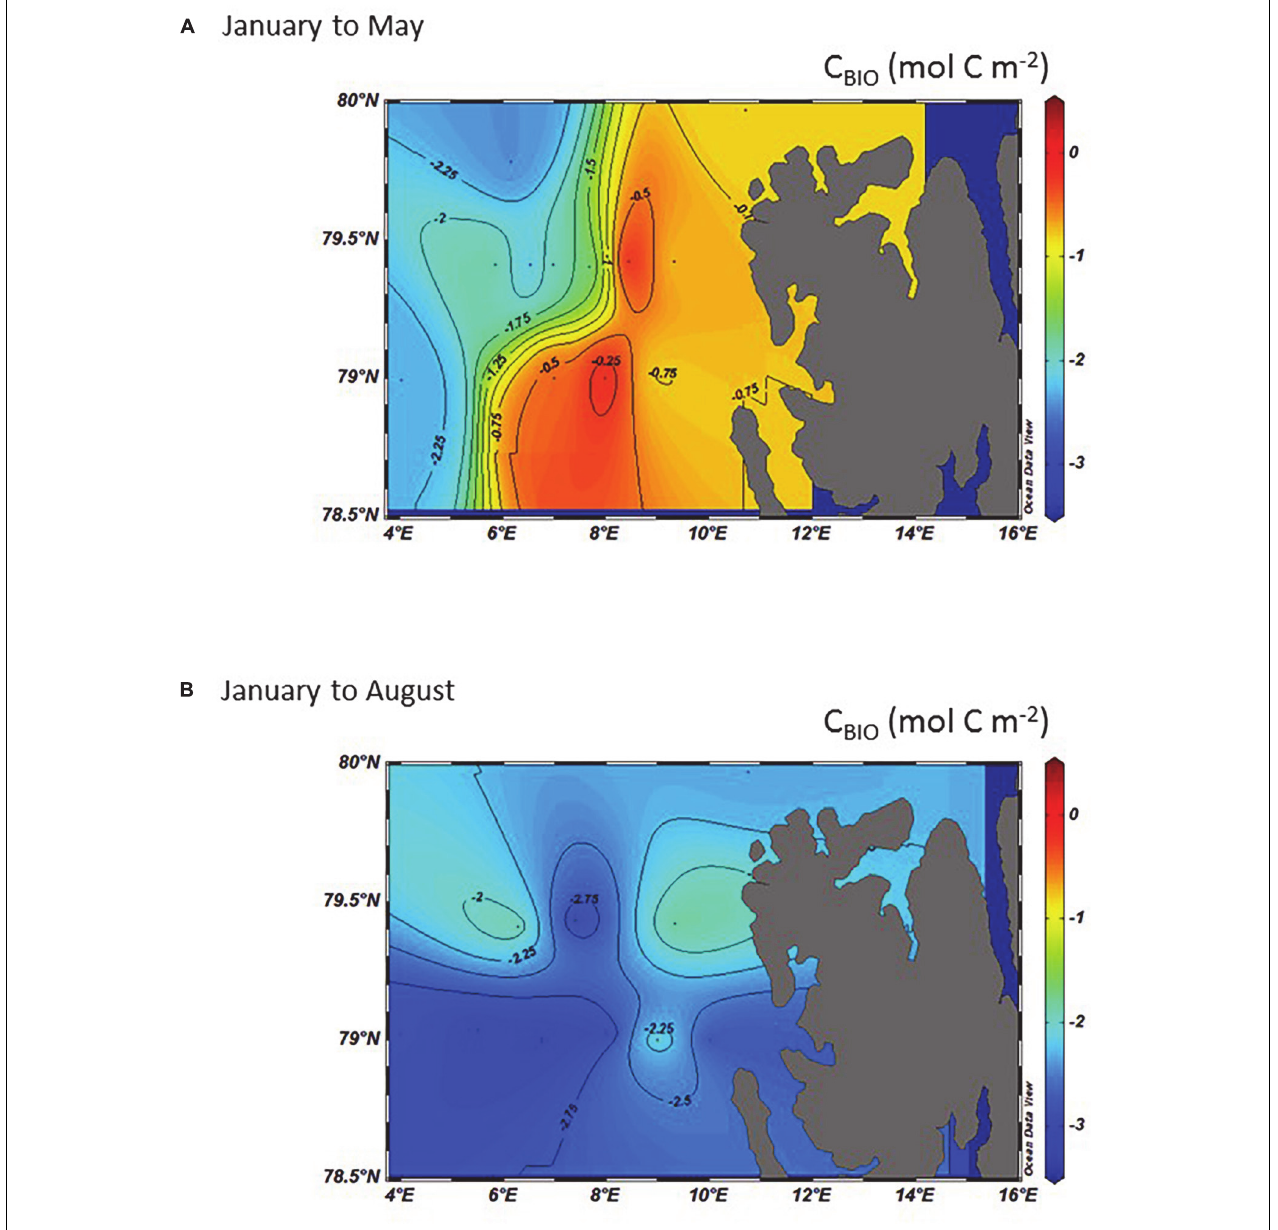
FIGURE 8 | Interpolated and integrated C BIO in the top 50 m (mol C m − 2 ) calculated from the difference between January and: (A) May and, (B) August in 2014. Negative numbers denote a loss of carbon through carbon consumption during phytoplankton production and a positive denote a gain of carbon during respiration and remineralization of organic